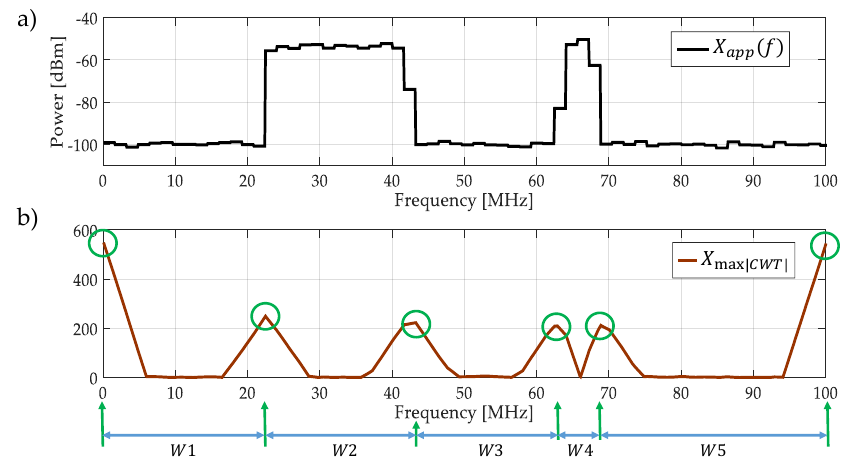
Figure 5. ( a ) X app ( f ) the approximation of X ( f ) . ( b ) The result of applying the continuous wavelet transform (CWT) modulus maxima to X app ( f ) at scale 120 and its corresponding detected edges.